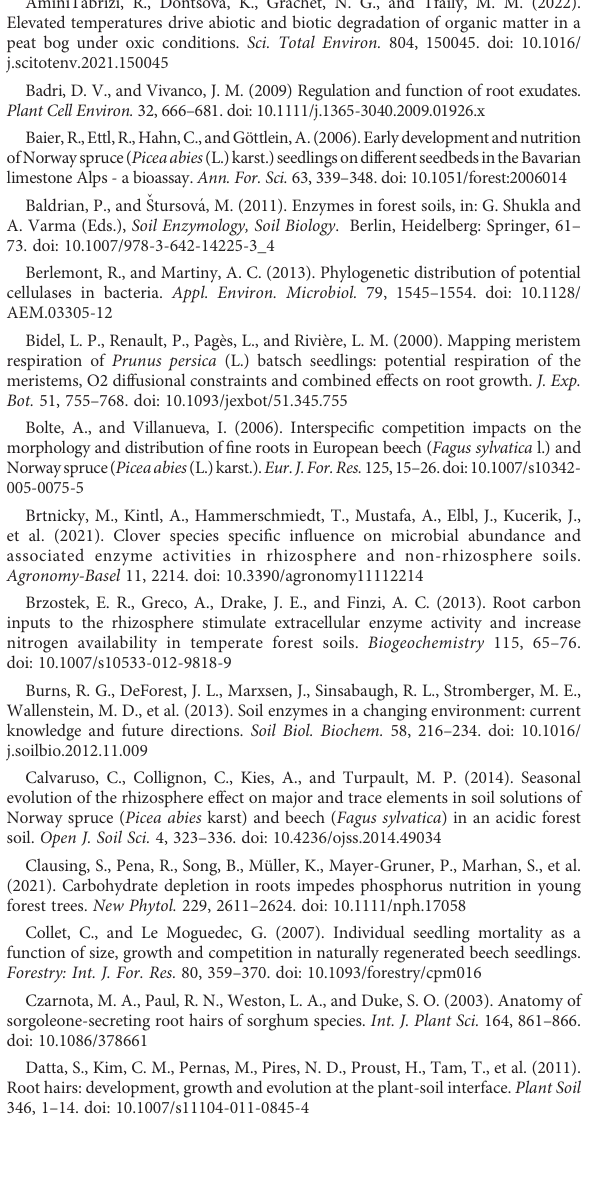
(J – L) . The models include data from 85 individual measuring points per plant. (N = 4). SUPPLEMENTARY FIGURE 2 Distribution of enzyme activities on the rhizoplane of Norway spruce. The curves present the power-law fi tting of enzyme activities as a function of vertical distance from the root apex in the regions of different root diameter (RD). Cellobiohydrolase (CBH); leucine- aminopeptidase (LAP); acid phosphomonoesterase (AP). RD